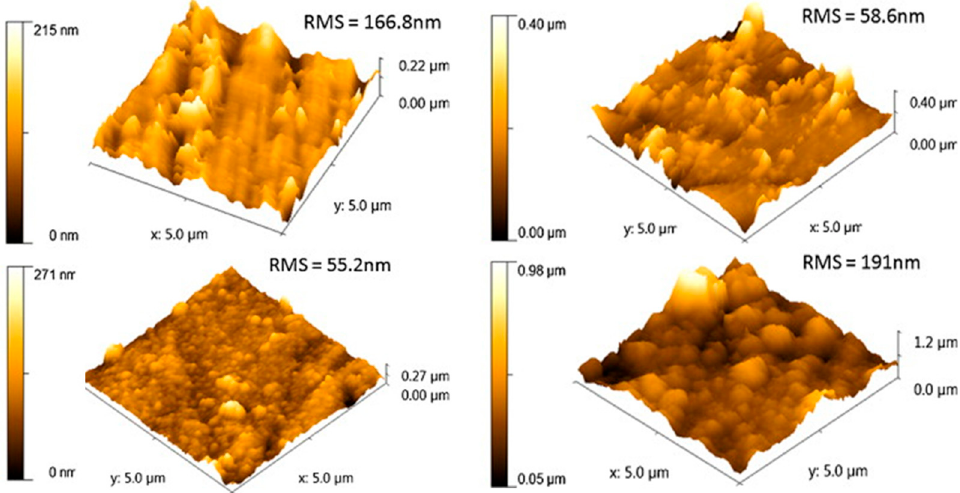
Figure 3. 3D atomic force microscopy (AFM) images for Ti/24PDA and Ti/72PDA. Below, Ti/24PDA–PPy and Ti/72PDA–PPy. (Reprinted with permissions from [73], Elsevier 2014 copyright n. 4710121133177).